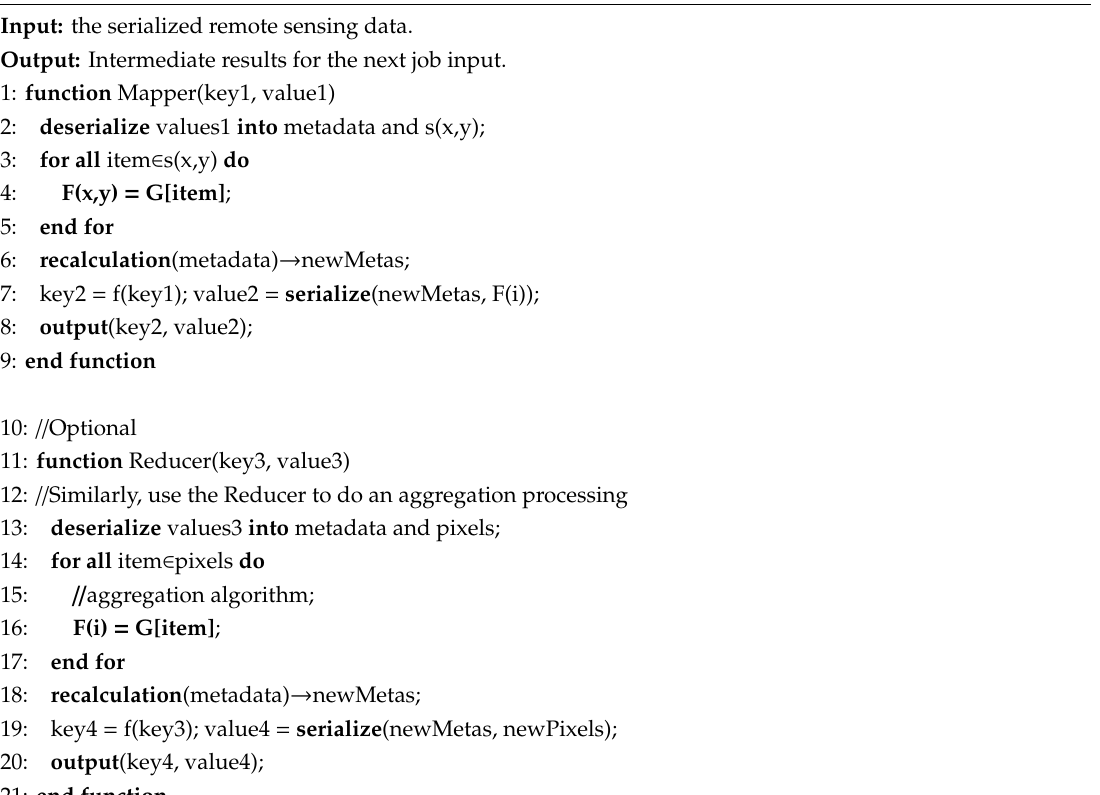
Algorithm 4: The cloud computing model for Neighborhood Operation